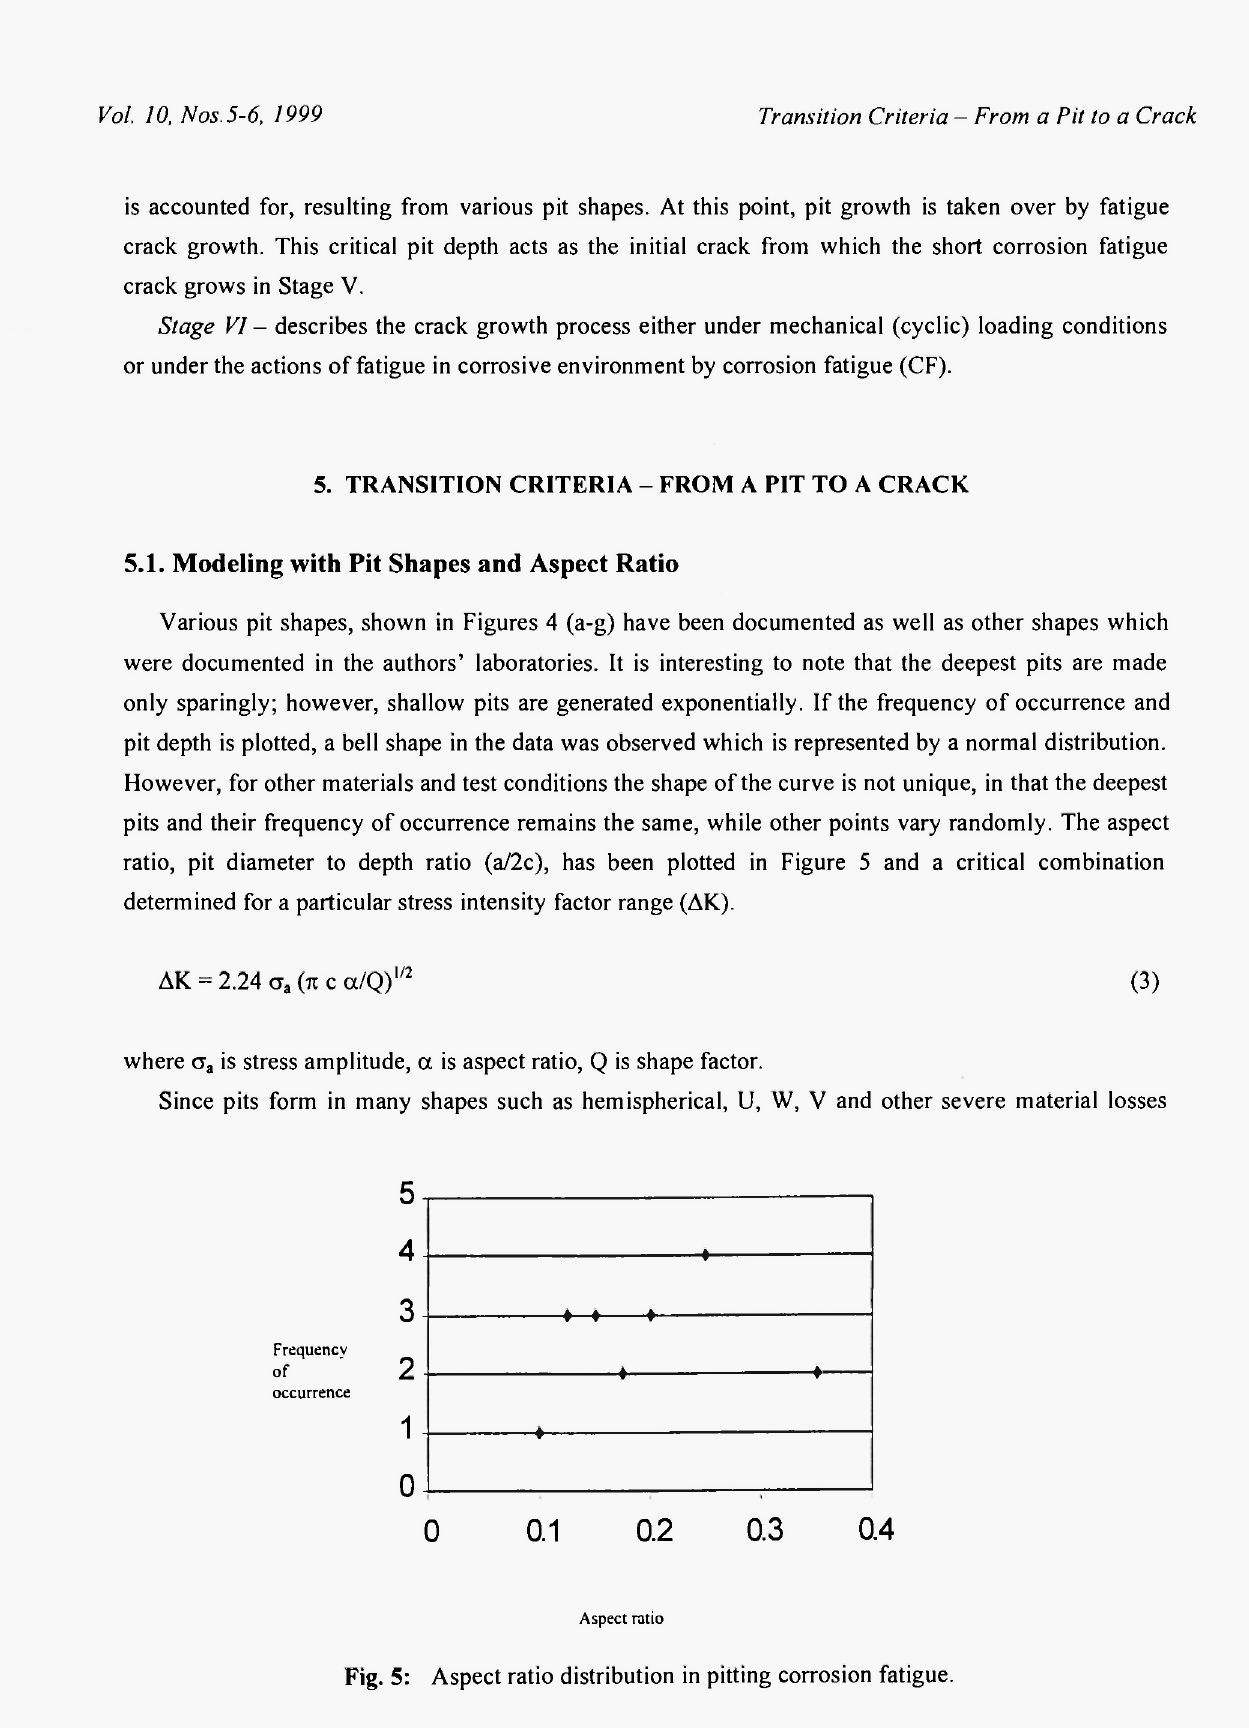
Fig. 5: Aspect ratio distribution in pitting corrosion